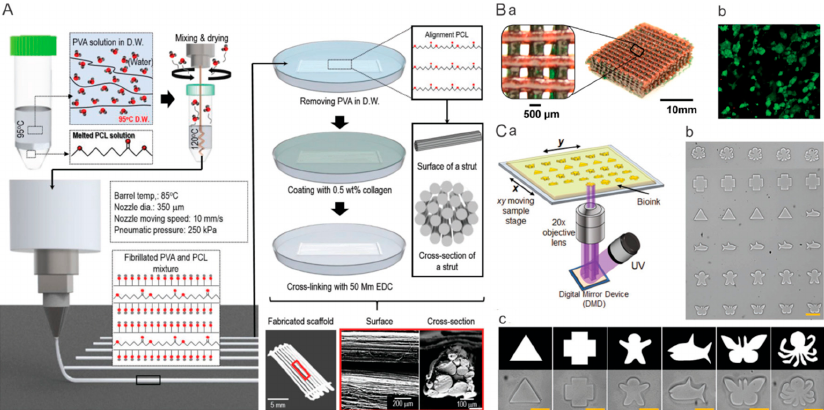
Figure 3. Representative 3D complex scaffolds prepared by 3D printing. ( A ) Schematic of fabrication process and photograph/SEM images of aligned microfibrillated PCL/collagen scaffold. Reprinted from Reference [34]. ( B ) Extrusion-based 3D printing: ( a ) 3D printed hydrogel, ( b ) live–dead assay,